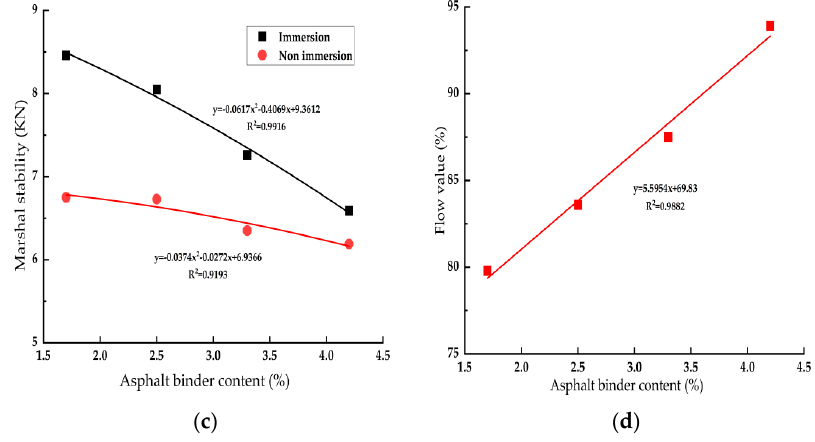
Figure 9. Water immersion Marshall stability test results of E/RAP and F/RAP. ( a ) Water immersion Marshall stability of E/RAP with various asphalt binder contents. ( b ) Flow value with various asphalt binder contents. ( c ) Water immersion Marshall stability of F/RAP with various asphalt binder contents. ( d ) Flow value of F/RAP with various asphalt binder contents.